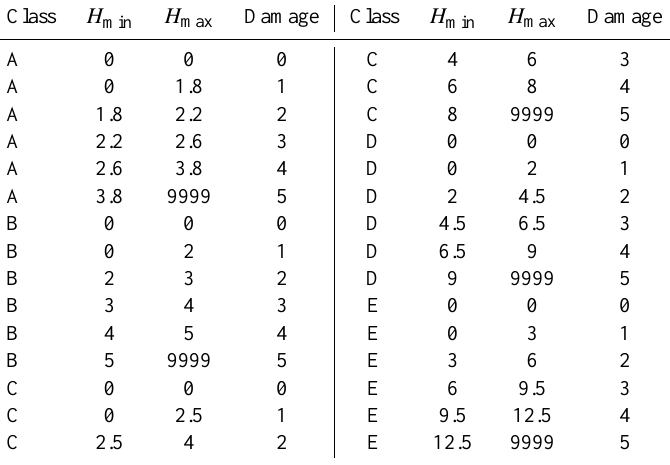
Table 5. Damage Table.